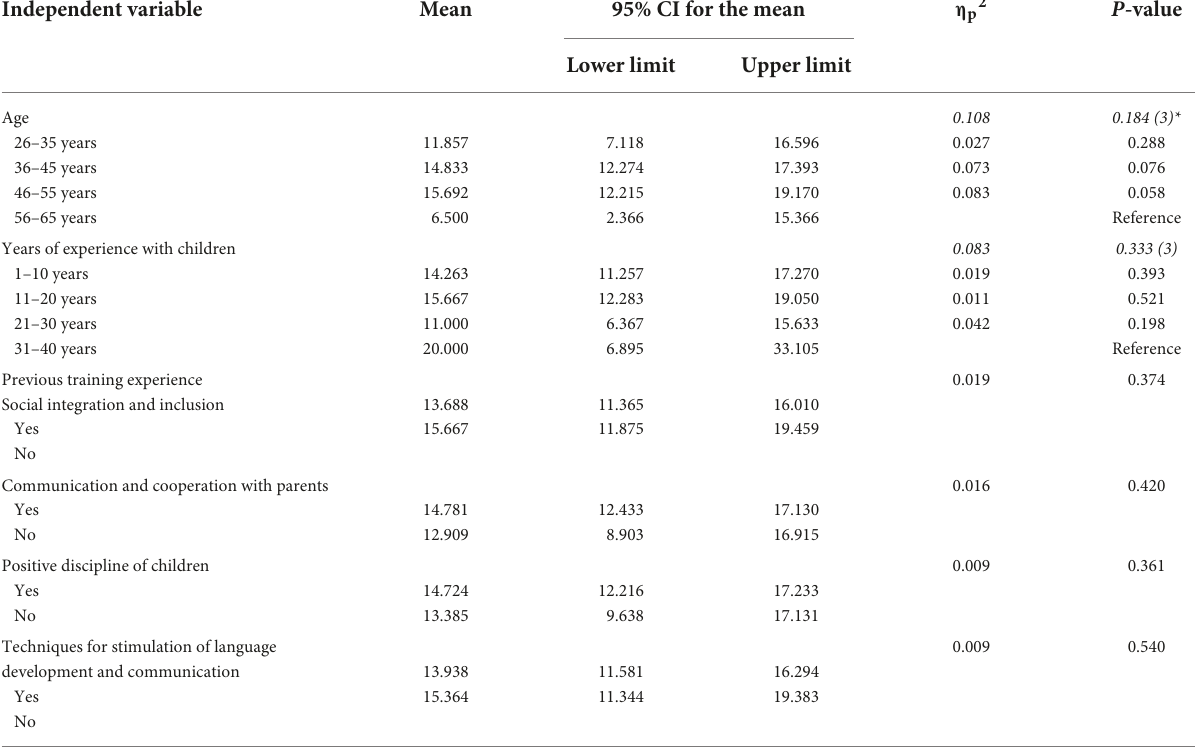
TABLE 2 The impact of training on overall knowledge and skills scores: Mean values of pre-post-test differences in the general linear model. Independent